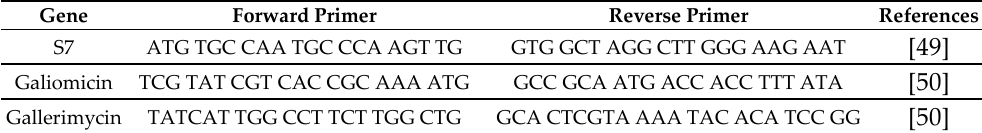
Table 1. Primers sequence of G. mellonella antimicrobial peptides.